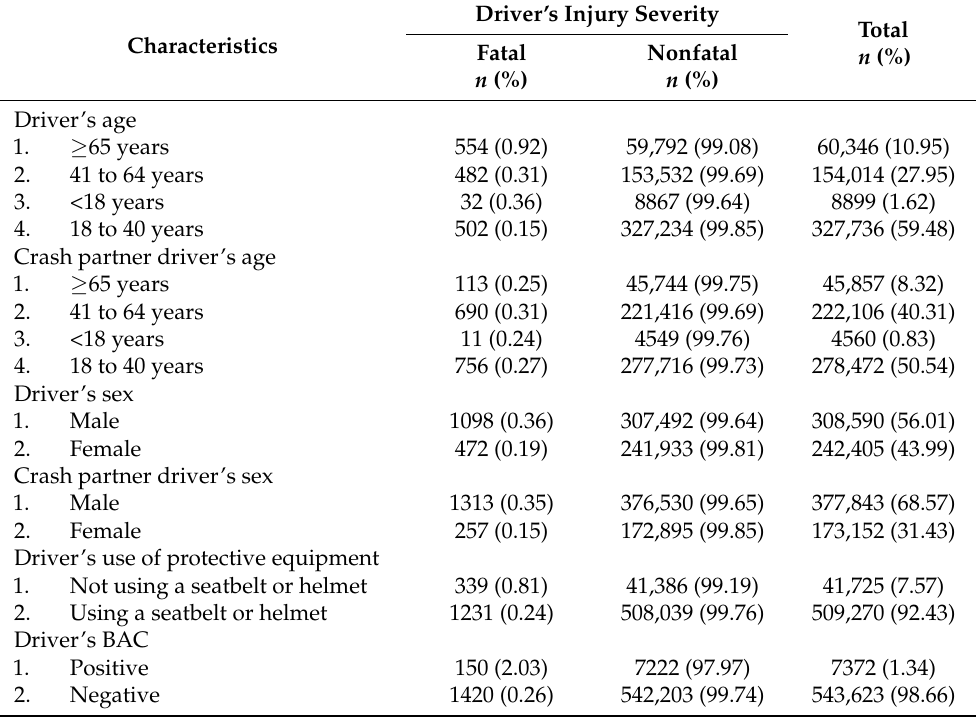
Table 2. Characteristics of